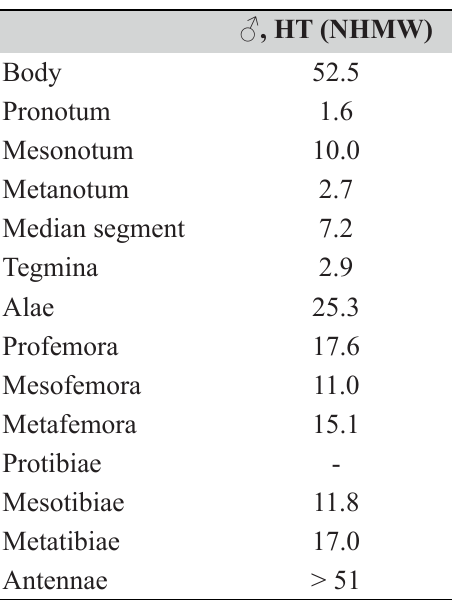
Table 6. Measurements of Phantasca montana (Redtenbacher, 1908) comb. nov. (in mm). HT =